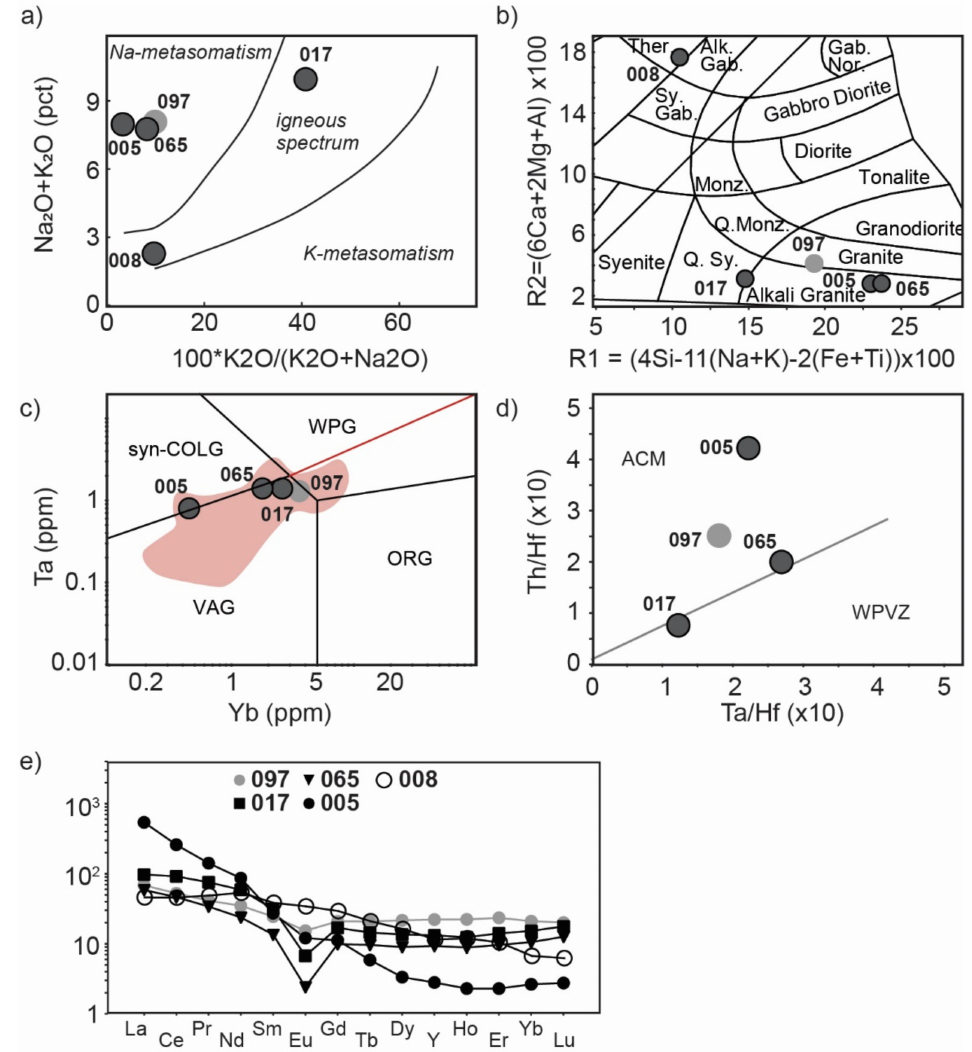
Figure 7. ( a ) Metasomatism diagram after Hughes [88]; ( b ) R1–R2 plutonic rock classification diagram [89]. Ther. = Theralite, Alk. Gab. = alkali gabbro, Gab. Nor. = gabbro norite, Sy. Gab. = syeno gabbro, Monz. = monzonite, Q. Monz. = quartz monzonite, Q. Sy. = quartz syenite. ( c ) Classification diagram for granitic rocks. Syn-COLG = syncollisional, WPG = within plate granite, VAG = volcanic arc granite, ORG = orogenic granite [90]. Pink field marks the Yb vs. Ta values of regional PMS samples [31]; ( d ) Ta/Hf vs. Th/Hf diagram delineating tectonic environments. ACM = active continental margin, WPVZ = within-plate volcanic zone [91]; ( e ) REE normalized to C1 Chondrite after Sun and McDonough